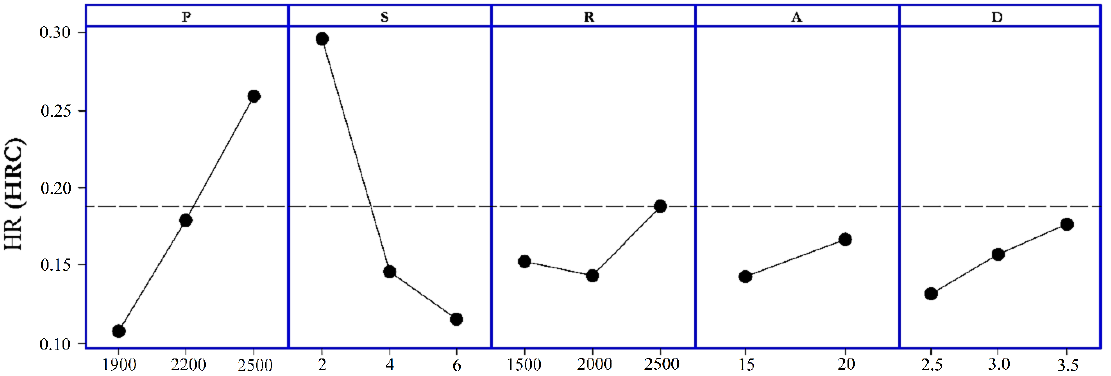
Figure 5. Effects of process parameters on the case depth at the root of spline’s tooth ( H R ), the unit of parameters are laser power (P) in [W] scanning speed (S) in [mm/s], rotational speed (R) in [rpm], flank tilt angle (A) in degrees, and tooth depth (D) in [mm].